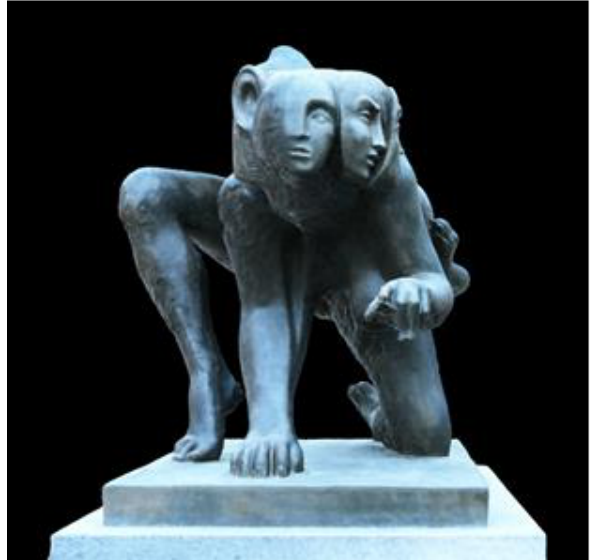
Figure 10. Neural volumetric raytracing of model of the statue of Alba Gonzalez, front